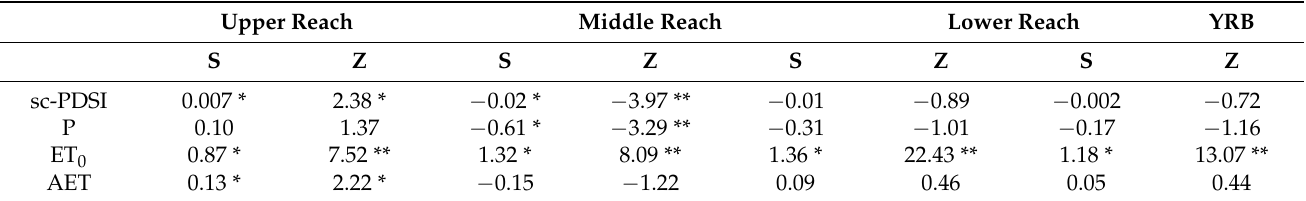
Table 2. Trend magnitudes using Sen’s slope and Z statistic in the YRB from 1951 to